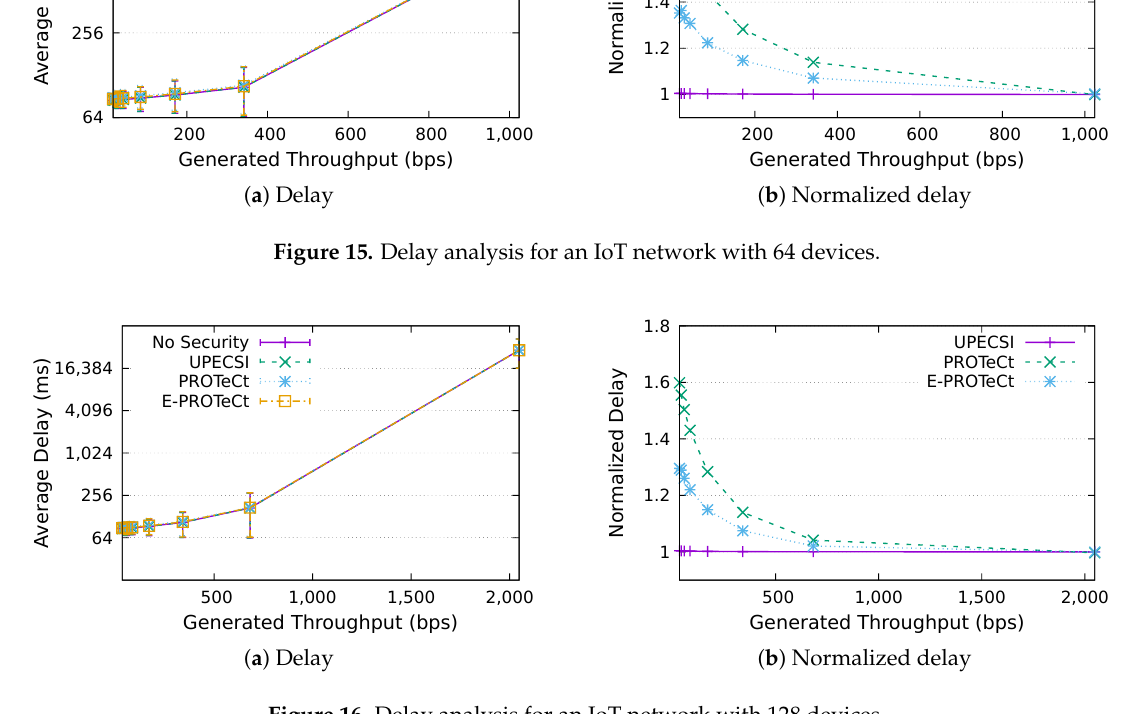
Figure 16. Delay analysis for an IoT network with 128 devices.